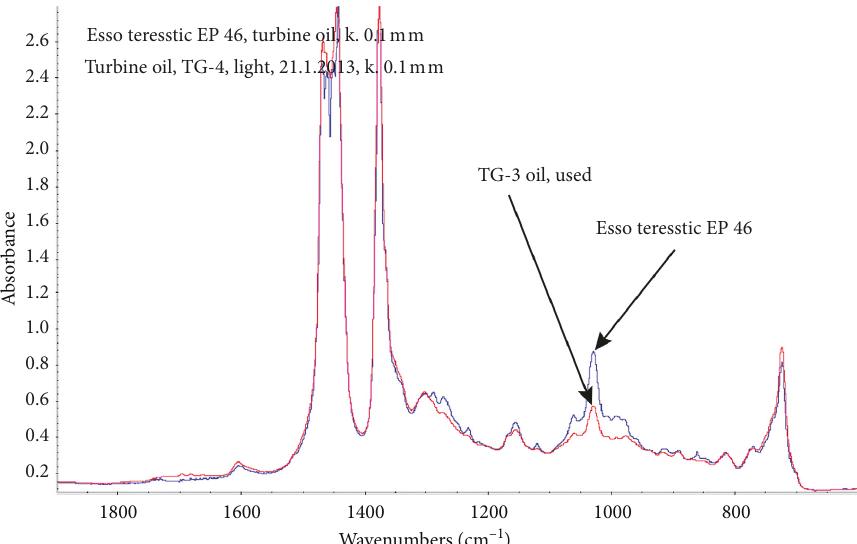
Figure 7: Comparison of FTIR spectra in terms of consumption of additives in the TG3 gear